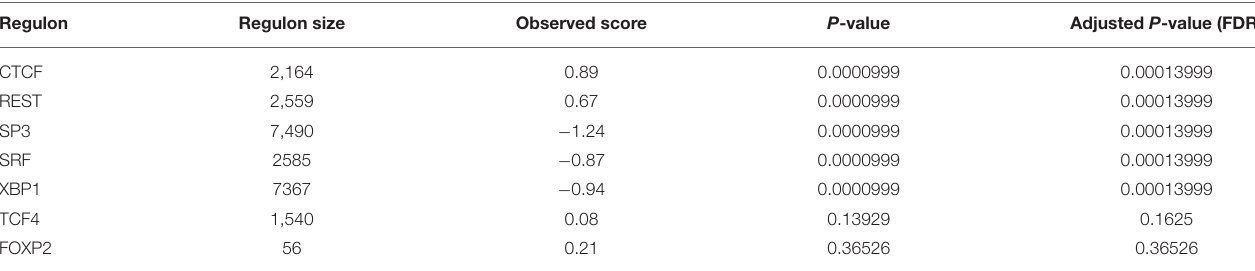
TABLE 3 | List of seven regulons identified from GSEA-2T among which five significant regulons were identified with FDR < 1.3e-4.